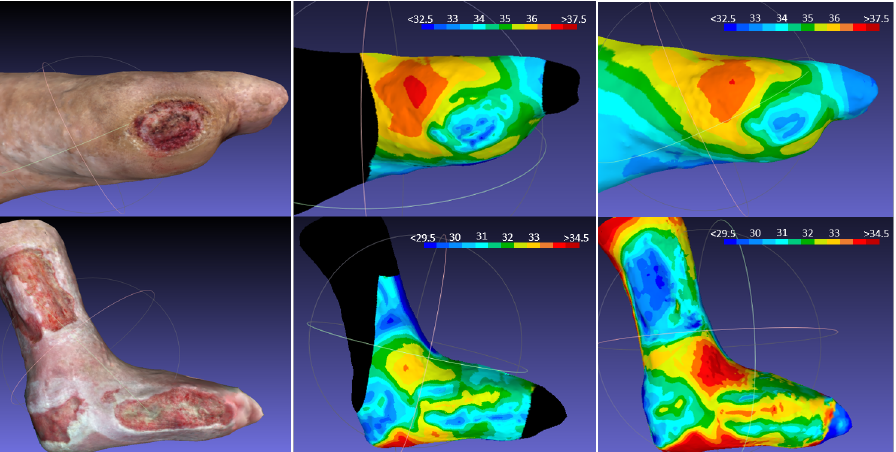
Figure 5. Illustration of the proposed process with two real cases: ( left ) color 3D models, ( center ) single-view thermal mapping, and ( right ) multi-view 3D surface thermography. Extensive coverage of thermal information is shown in the multi-view 3D thermal model compared to the single view.